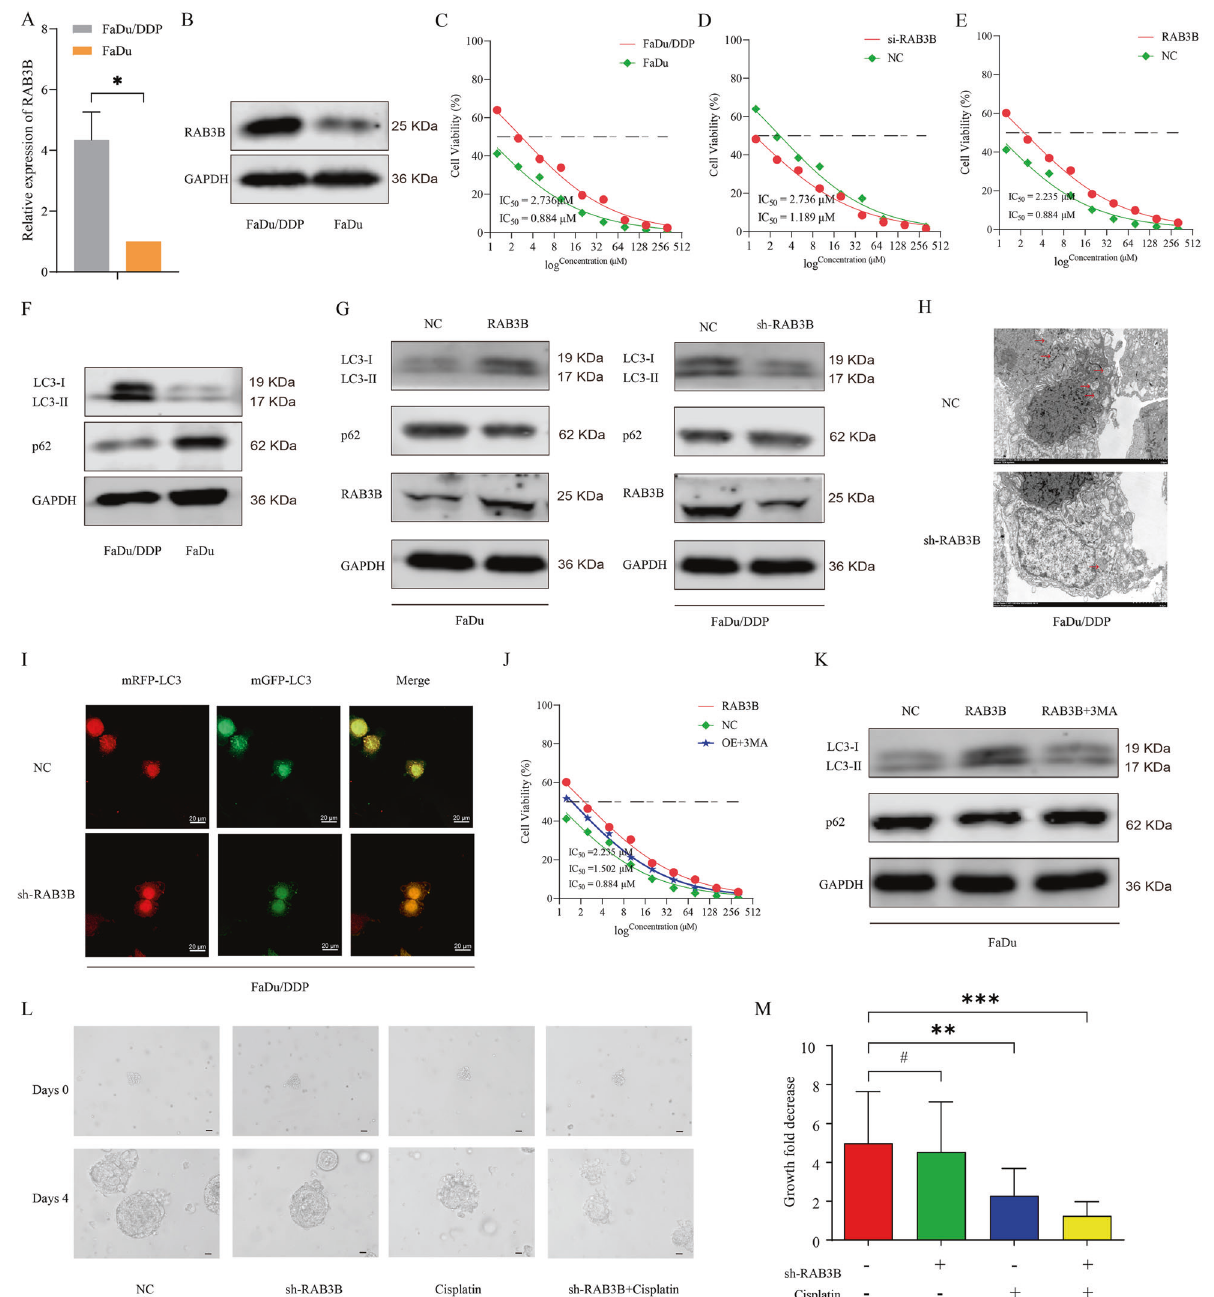
Fig. 5 RAB3B could promote the DDP resistance of HSCC by inducing autophagy. A Relative mRNA expression of RAB3B in FaDu/DDP cells and FaDu cells was determined by qRT-PCR. B Expression of RAB3B in FaDu/DDP cells and FaDu cells was determined by Western blot. C Sensitivities of FaDu/DDP cells and FaDu cells under different concentrations of DDP were determined by CCK-8 assay. D Sensitivities of FaDu/DDP cells infected with RAB3B shRNA or not under different concentrations of DDP were determined by CCK-8 assay. E Sensitivities of FaDu cells transfected with RAB3B overexpression plasmid or not under different concentrations of DDP were determined by CCK-8 assay. F Protein levels of LC3B and p62 in FaDu/DDP cells and FaDu cells were determined by Western blot. G Protein levels of LC3B and p62 in FaDu/ DDP cells infected with RAB3B shRNA or not were determined by Western blot, and the protein levels of LC3B and p62 in FaDu cells transfected with RAB3B overexpression plasmid or not were determined by Western blot. H Autophagy was evaluated in FaDu/DDP cells infected with RAB3B shRNA or not using TEM. I FaDu/DDP cells stably expressing stubRFP-sensGFP-LC3 under shRNA transfection were observed by fl uorescence microscopy. J Sensitivities of FaDu cells transfected with RAB3B overexpression plasmid, cotransfected with RAB3B overexpression plasmid and 3MA or not under different concentrations of DDP were determined by CCK-8 assay. K Protein levels of LC3B and p62 in FaDu cells transfected with RAB3B overexpression plasmid, cotransfected with RAB3B overexpression plasmid and 3-MA or not were determined by Western blot. L Effects of sh-RAB3B and/or DDP on the viability of PDO (scale bar, 100 μ m). M Measurement of the growth of PDO in response to knockdown of RAB3B and DDP. Data are the means ± SD ( n = 3 independent experiments); * p < 0.05, ** p < 0.01, *** p < 0.001, # p >